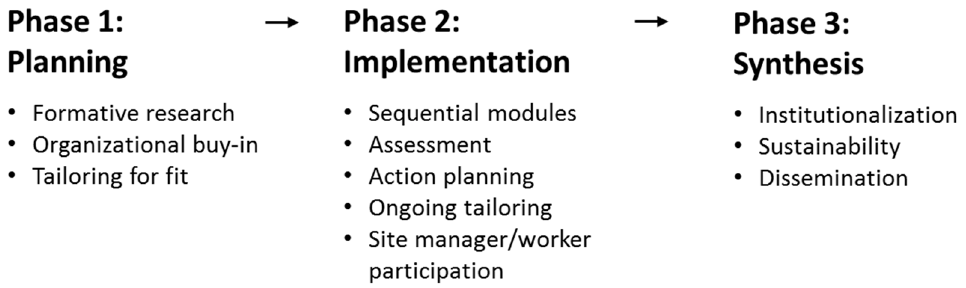
Figure 1. Intervention Framework.